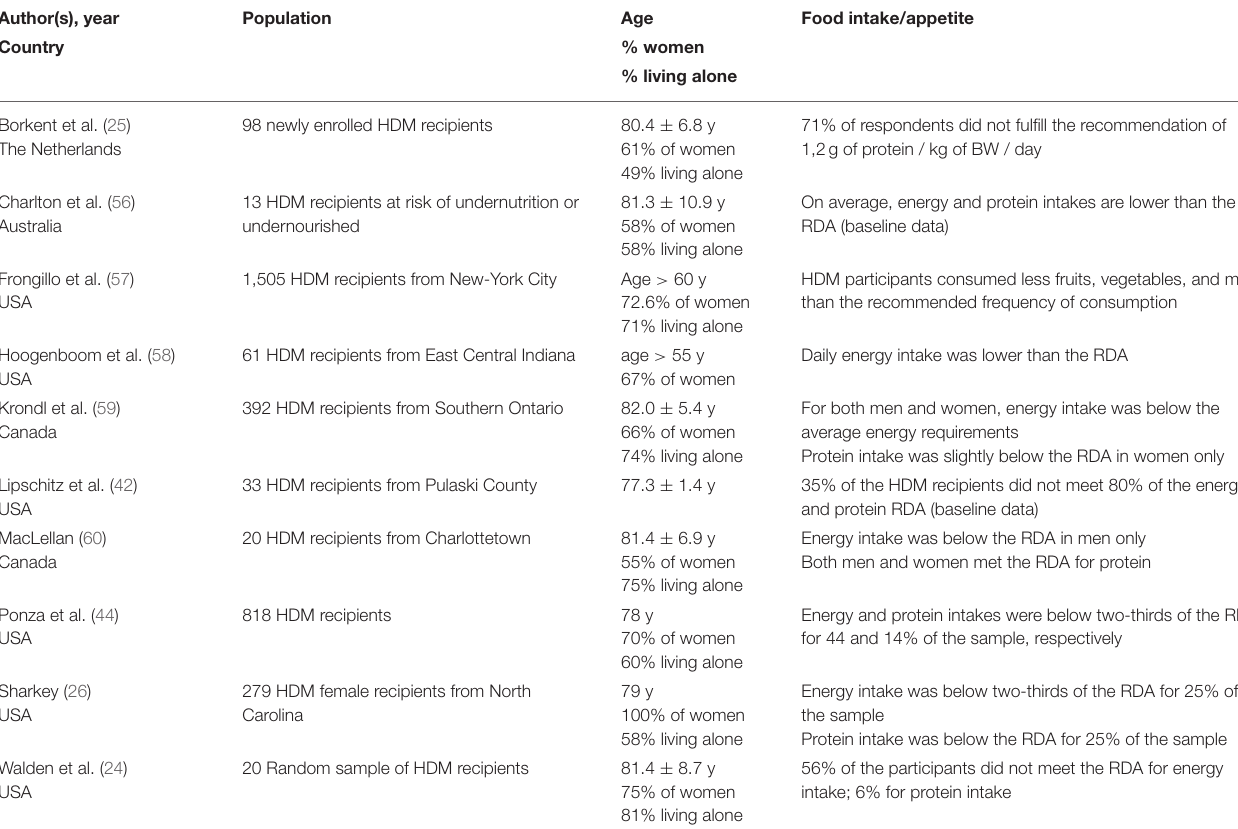
TABLE 3 | Food intake in HDM